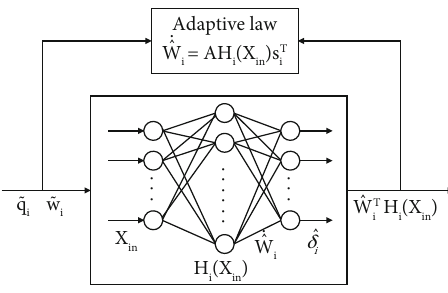
Figure 1: Adaptive RBFNN